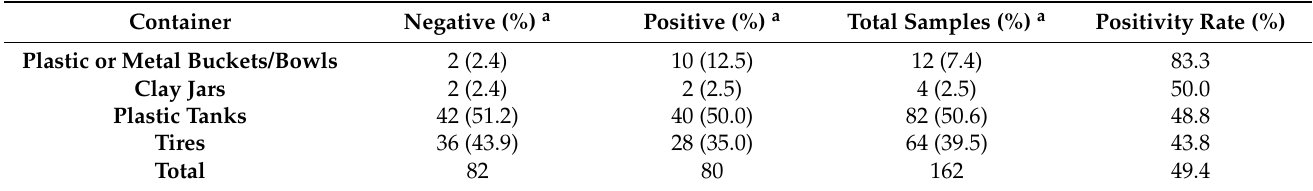
Table 2. Proportions of containers found positive with either Aedes larvae or pupae in Gewane District, Ethiopia,